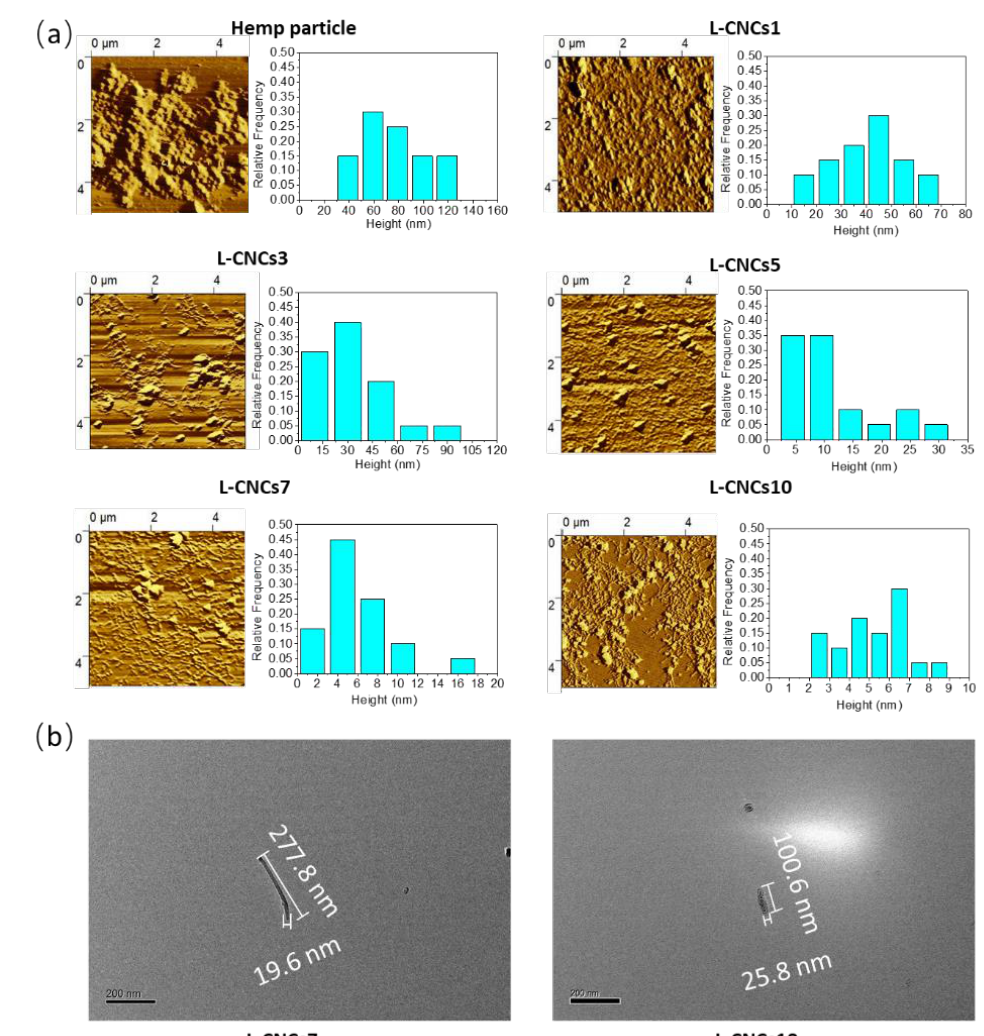
Figure 3. ( a ) AFM image and height of hemp particle and L-CNCs samples. ( b ) TEM image of rod-like L-CNCs7 and L- CNCs10 particle.